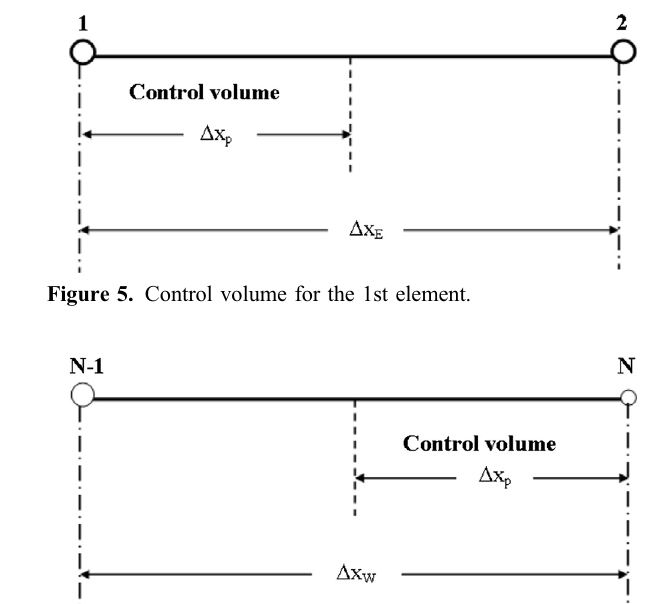
Figure 4. Normal control volume element for one-dimensional problems.